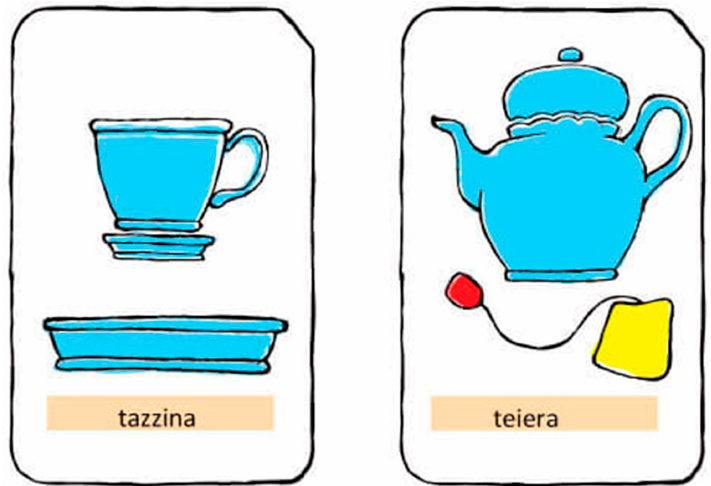
Figure 4. The playing cards depict similar and simple elements: one subject is the protagonist; the second is a subordinate and aggregate, which can be a cue of wonder, question, or necessity by stimulating the ability to relate the information. This mechanism, at the basis of fantastic elaboration, can lead into the imaginative process and, in the future, drives to creativity and